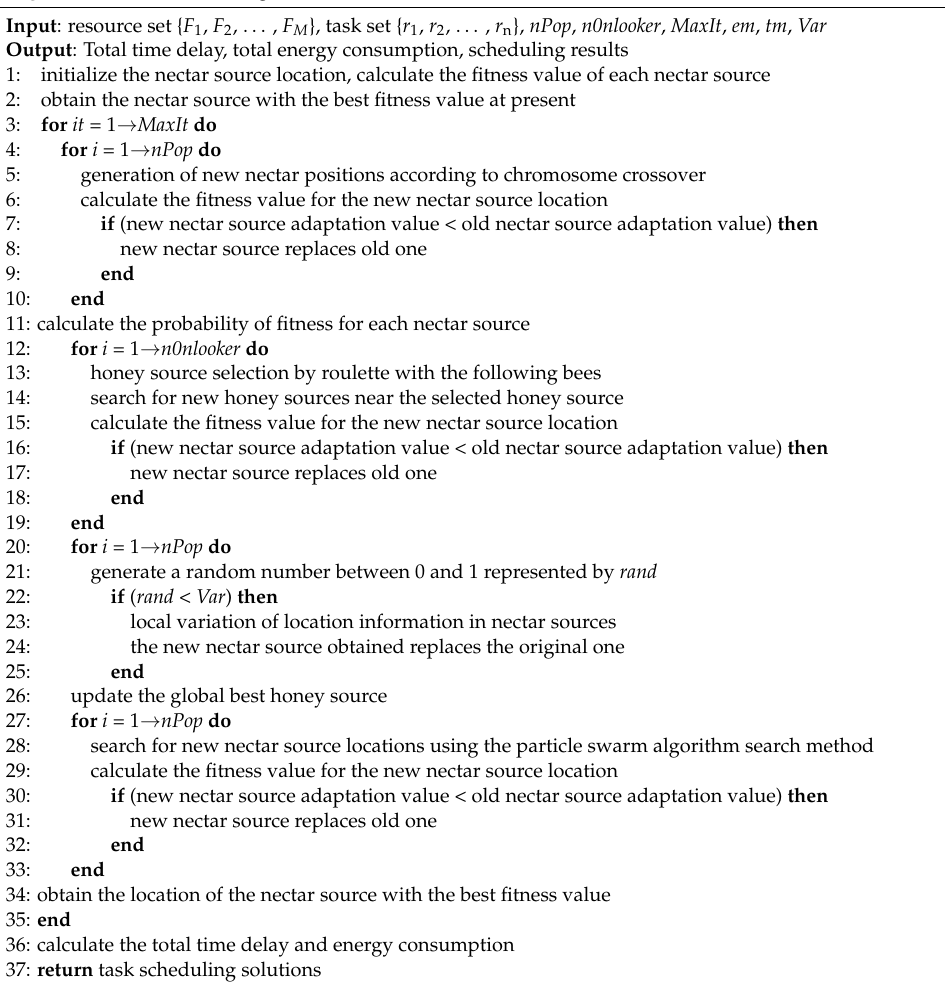
Algorithm 2: Task scheduling based on